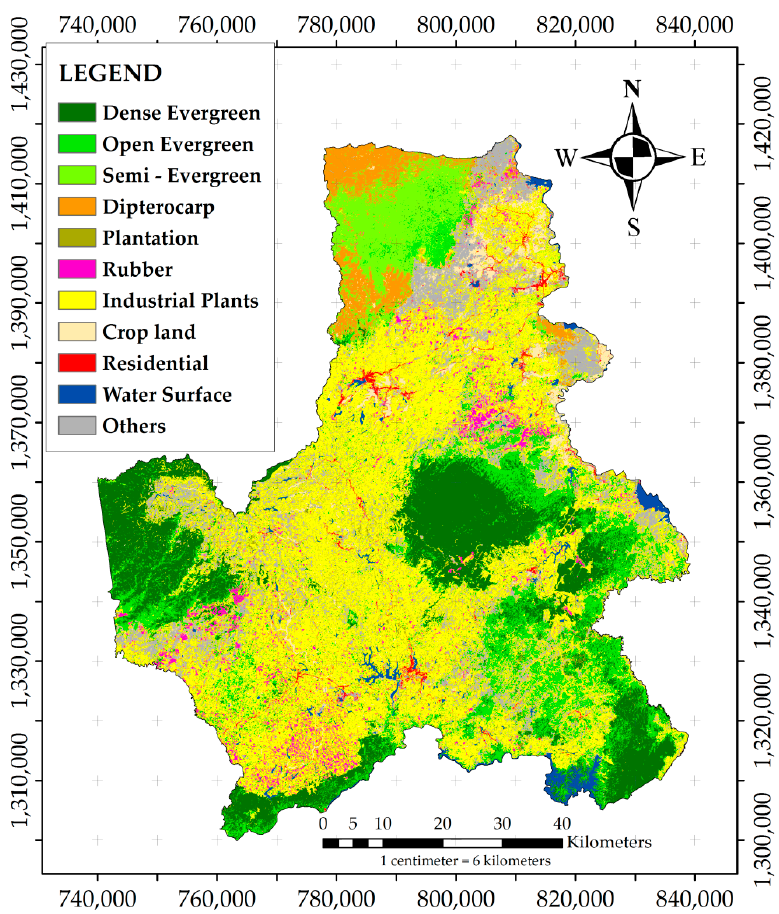
Figure 8. Land use and land cover (LULC) map produced for the most accurate classification combination.